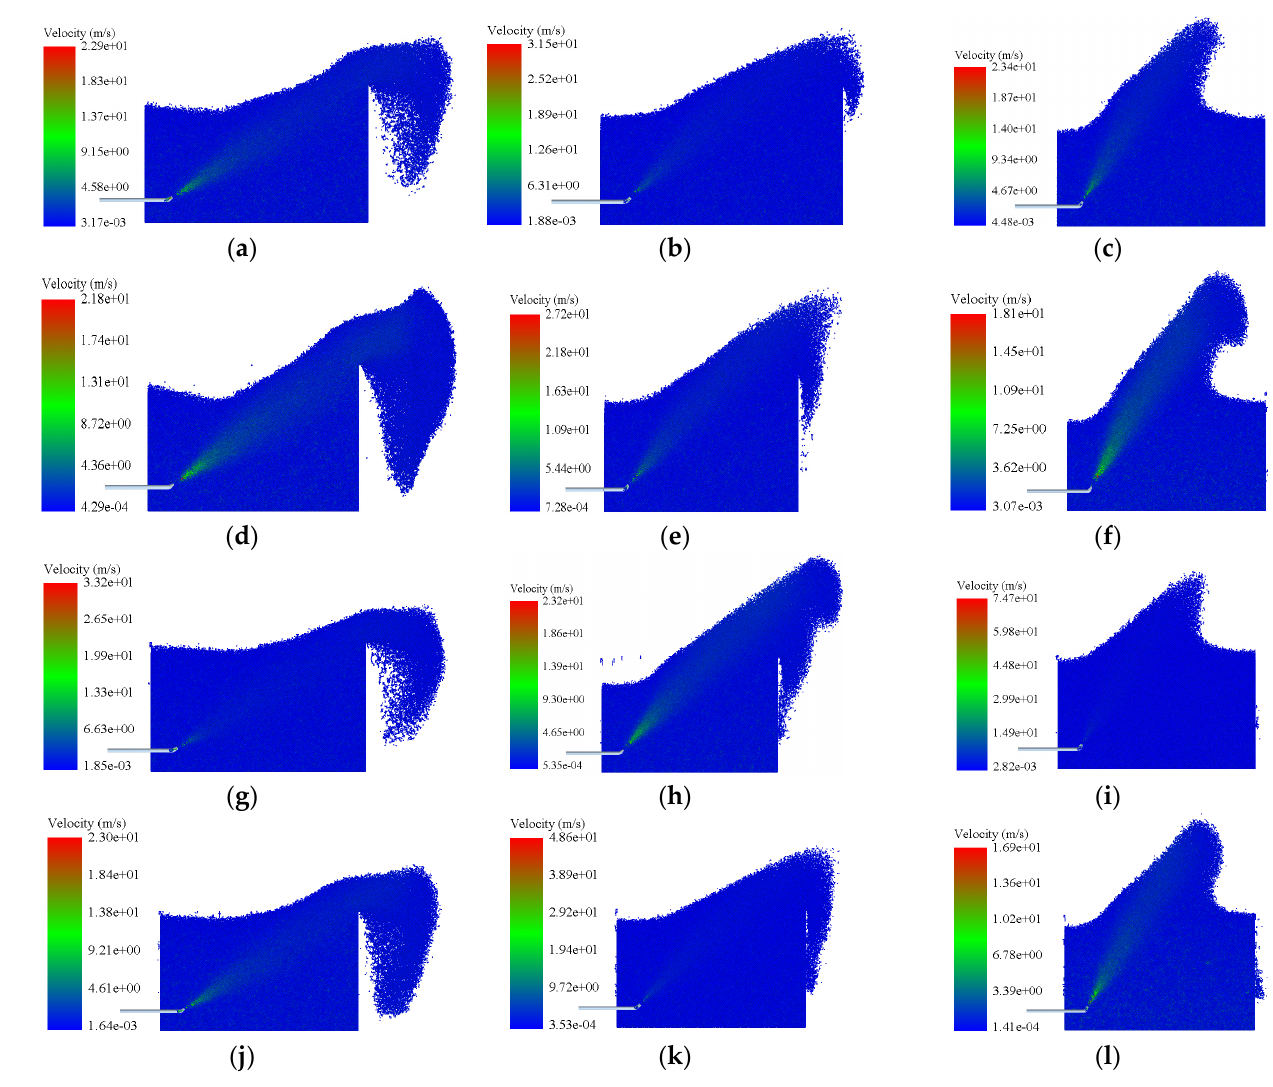
Figure 13. CFD-EDEM simulation results. The annotations in each subfigure indicate the nozzle diameter, angle and depth, respectively: ( a ) 6 mm × 30° × 400 mm, ( b ) 6 mm × 45° × 350 mm, ( c ) 6 mm × 60° × 400 mm, ( d ) 8 mm × 30° × 350 mm, ( e ) 8 mm × 45° × 400 mm, ( f ) 8 mm × 60° × 350 mm, (g) 8 mm × 30° × 450 mm, (h) 10 mm × 45° × 450 mm, ( i ) 8 mm × 60° × 450 mm, ( j ) 10 mm × 30° × 400 mm, ( k ) 10 mm × 45° × 350 mm, ( l ) 10 mm × 60° × 400 mm.